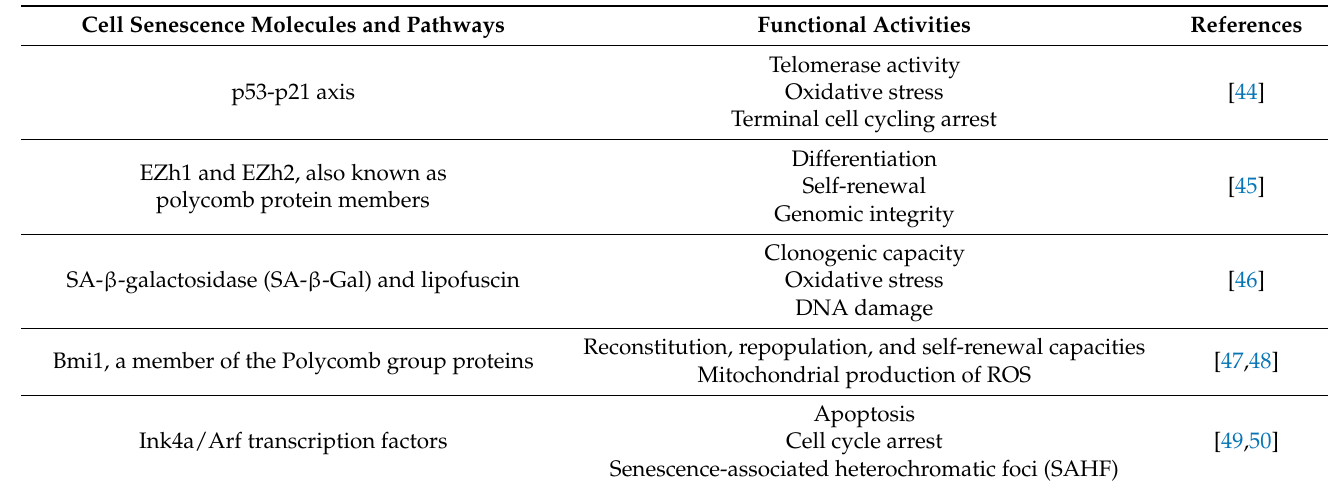
Table 1. Selected molecules and pathways in the regulation of HSC